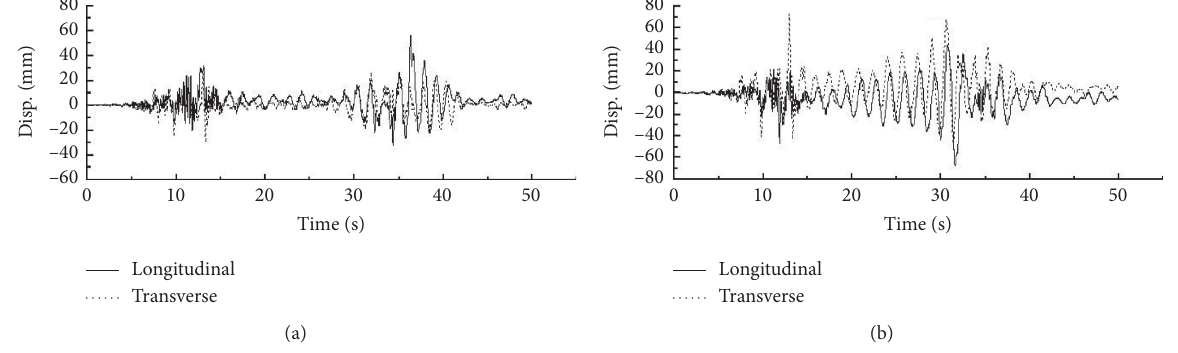
Figure 9: Displacement time histories of the bent tops. (a) Bent 2. (b) Bent 4.